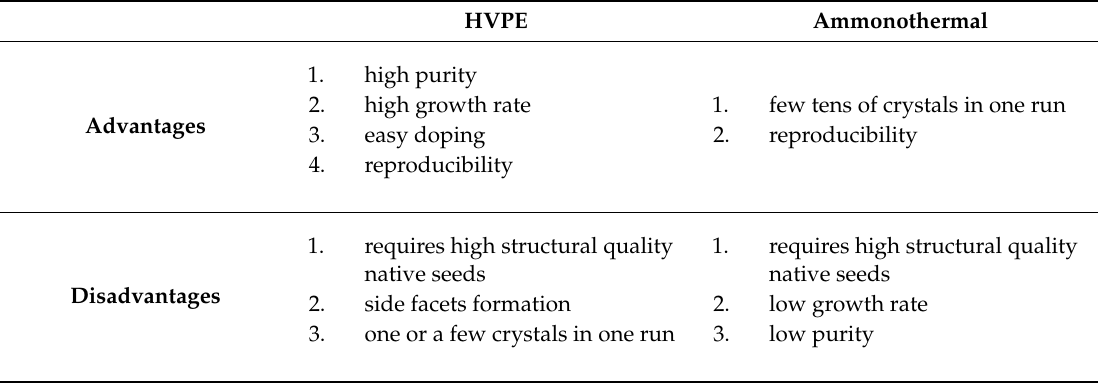
Table 1. Summarized advantages and disadvantages of HVPE and ammonothermal crystal growth methods.